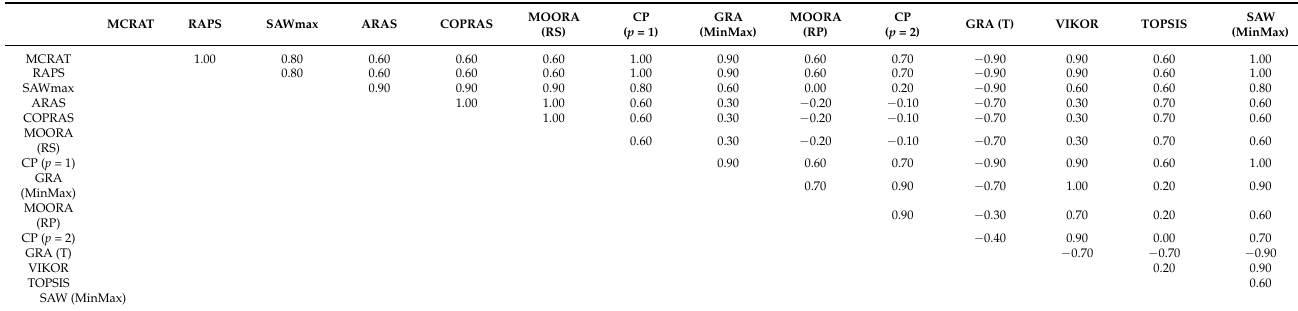
Table 8. Correlation of applied and novel methods.